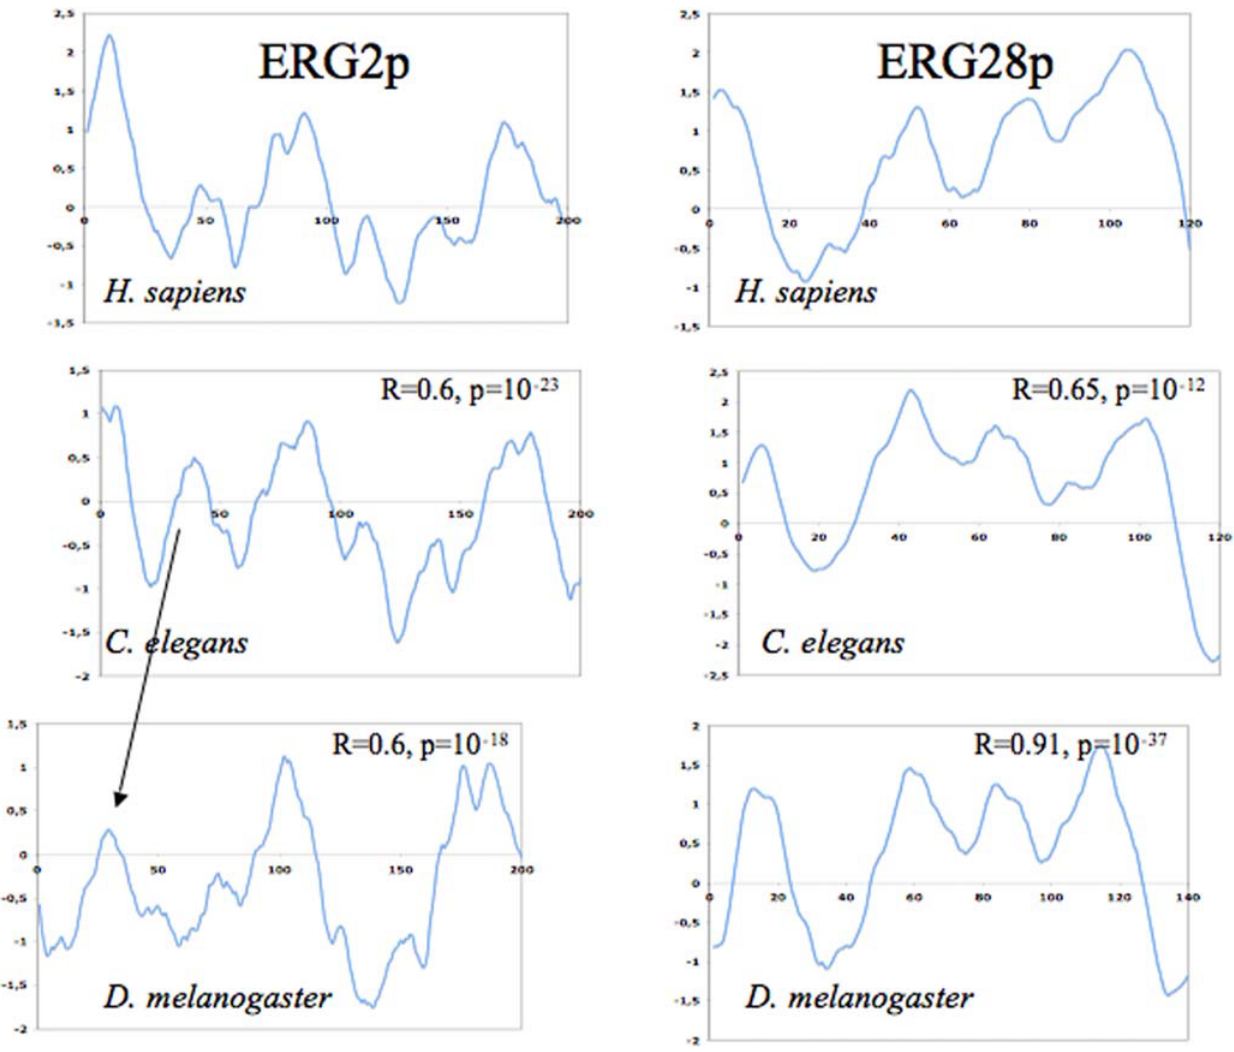
Figure 4. Hydrophobic profiles of several potential ERG orthologous proteins. A way to show a structural relationship is to predict the hydrophobic profiles of the relevant proteins. Here we have used the TopPred program [36] as implemented in the server of Pasteur Institute (http:// www.pasteur.fr). Left panels show the results for the potential homologs of ERG2p while the right panels display the profiles for ERG28p homologs (using the Kyte-Doolitle scale, with the default parameters). Negative (positive) values represent hydrophobic (hydrophilic) segments. A way to statistically assess the similarity of two profiles is to calculate their correlation coefficient R. R-values for pairwise comparisons with the human sequence are reported. We tried to maximize the R-value by slightly sliding one profile over the other (that is why the frames of the profiles are not perfectly aligned).